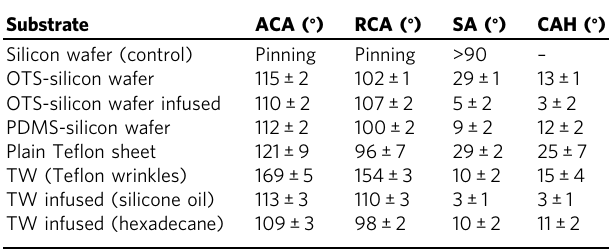
Mean value and standard deviation are shown. Nanoscale mapping of the lubricant layer . Equation (1) de fi nes